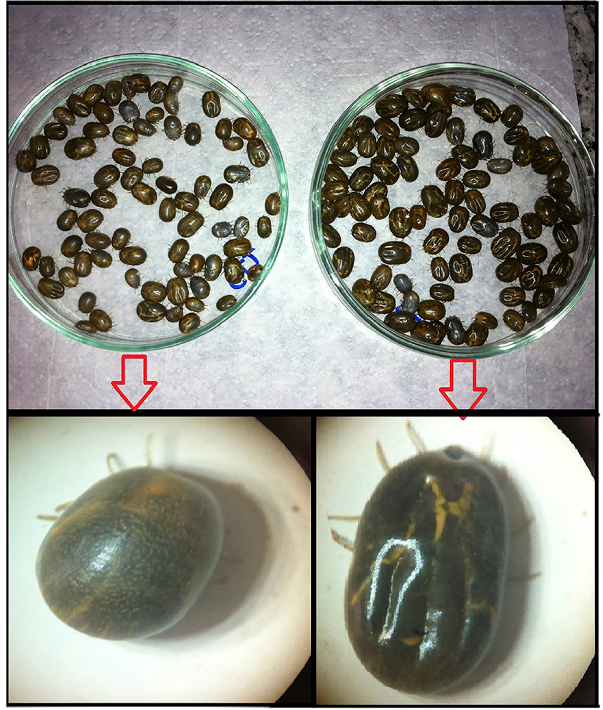
Figure 2. Comparison of the Rhipicephalus microplus females of the group exposed to fluazuron (left) and control (right) observed under a stereoscopic microscope, collected from the ground of stalls on the eighth day after treatment of the calves. Note the differences in shape, size and dorsal surface aspect of the females.